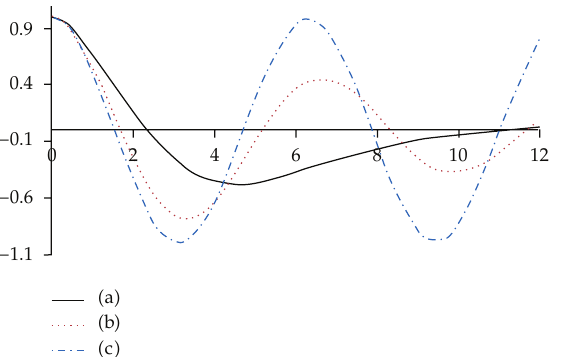
Figure 2: Numerical solutions of Example 4.1 for (cid:3) a (cid:4) k (cid:8) 1, (cid:3) b (cid:4) k (cid:8) 0 . 2,and (cid:3) c (cid:4) k (cid:8) 0 . 005.